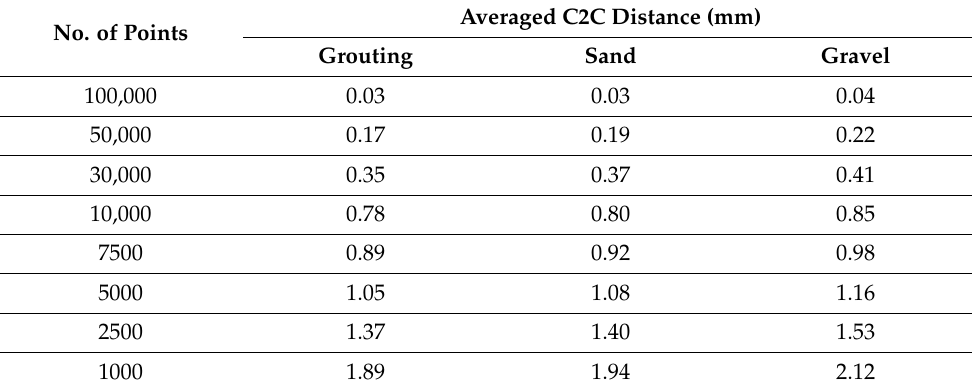
Figure 15. C2C results between subsamples with different density. Table 2. Averaged C2C distances of subsamples in different density.